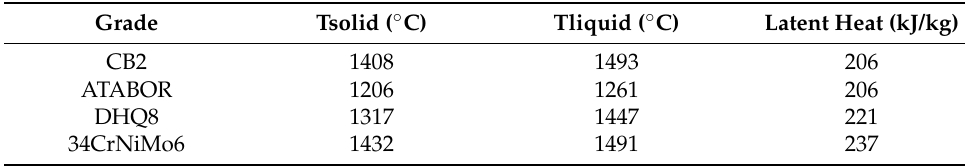
Table 3. Main thermodynamic